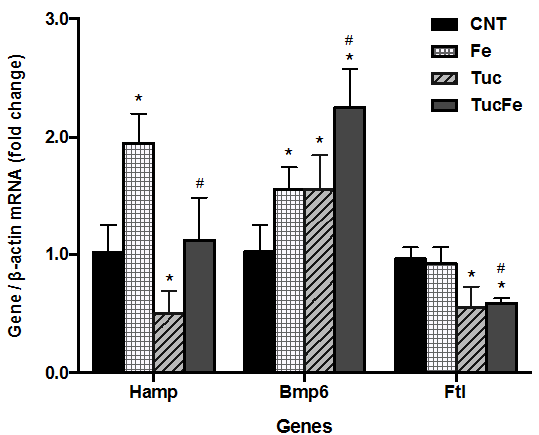
Figure 5. Quantification of hepatic mRNA levels of hepcidin (Hamp), bone morphogenetic protein 6 (Bmp6) and ferritin (Ftl), determined by qPCR. CNT, Control group; Fe, iron-enriched group, Tuc, tucum-do-cerrado group; TucFe, tucum-do-cerrado iron-enriched group. Data are the means ˘ SD, 8 ( n = 6). Significant differences ( p < 0.05): * Comparison to the Control group; # Comparison to the Fe